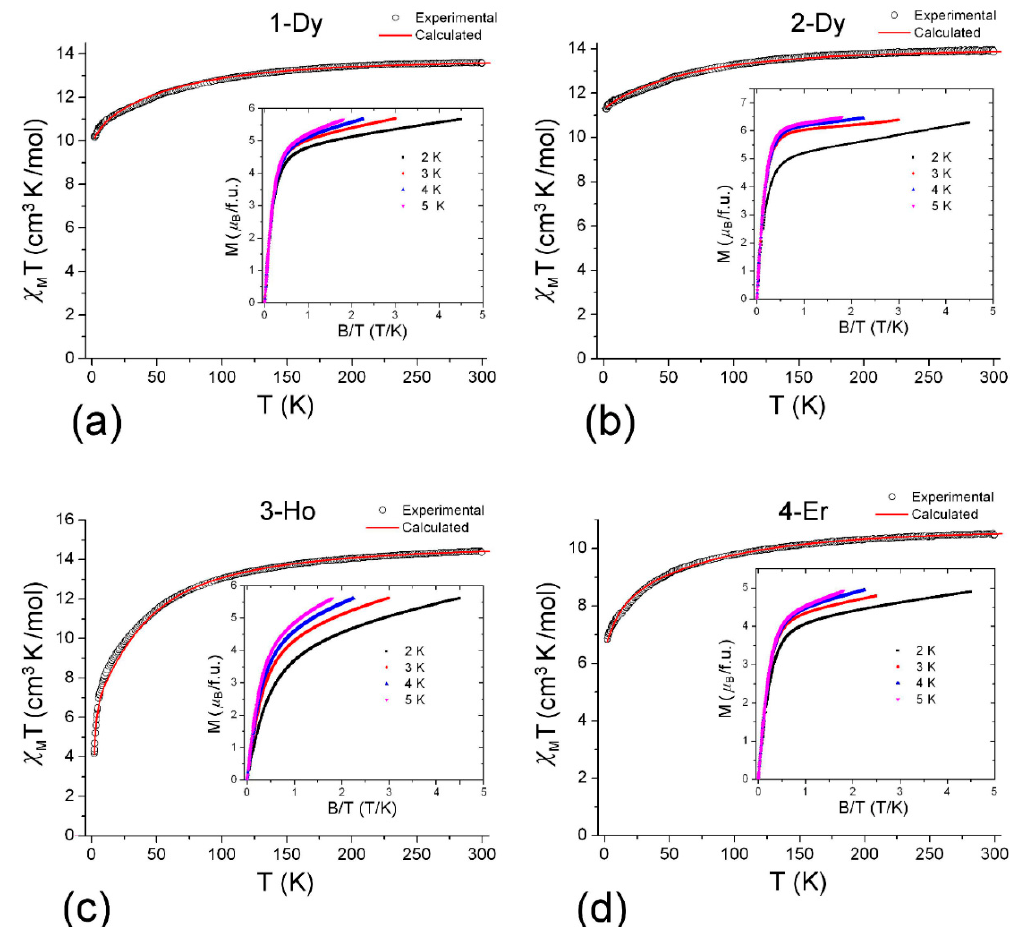
Figure 6. Experimental (open circles) and calculated (solid red lines) temperature dependence of the χ M T product under dc field of 1000 Oe for complexes: ( a ) 1-Dy ; ( b ) 2-Dy ; ( c ) 3-Ho and ( d ) 4-Er . Insets: M / µ B vs. B / T plots within the field range of 0–4.5 T and temperature range of 2–5 K.